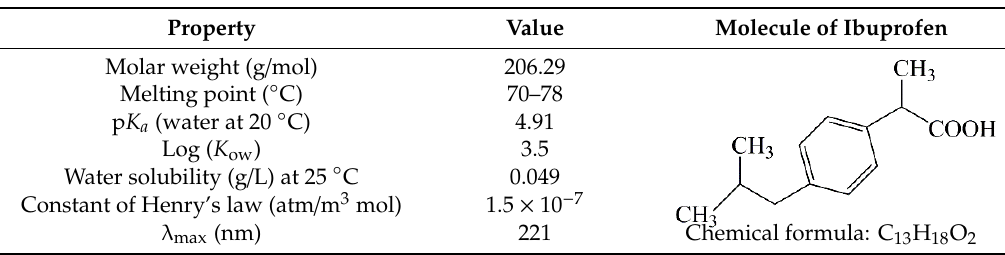
Table 2. Physicochemical properties of IBU.